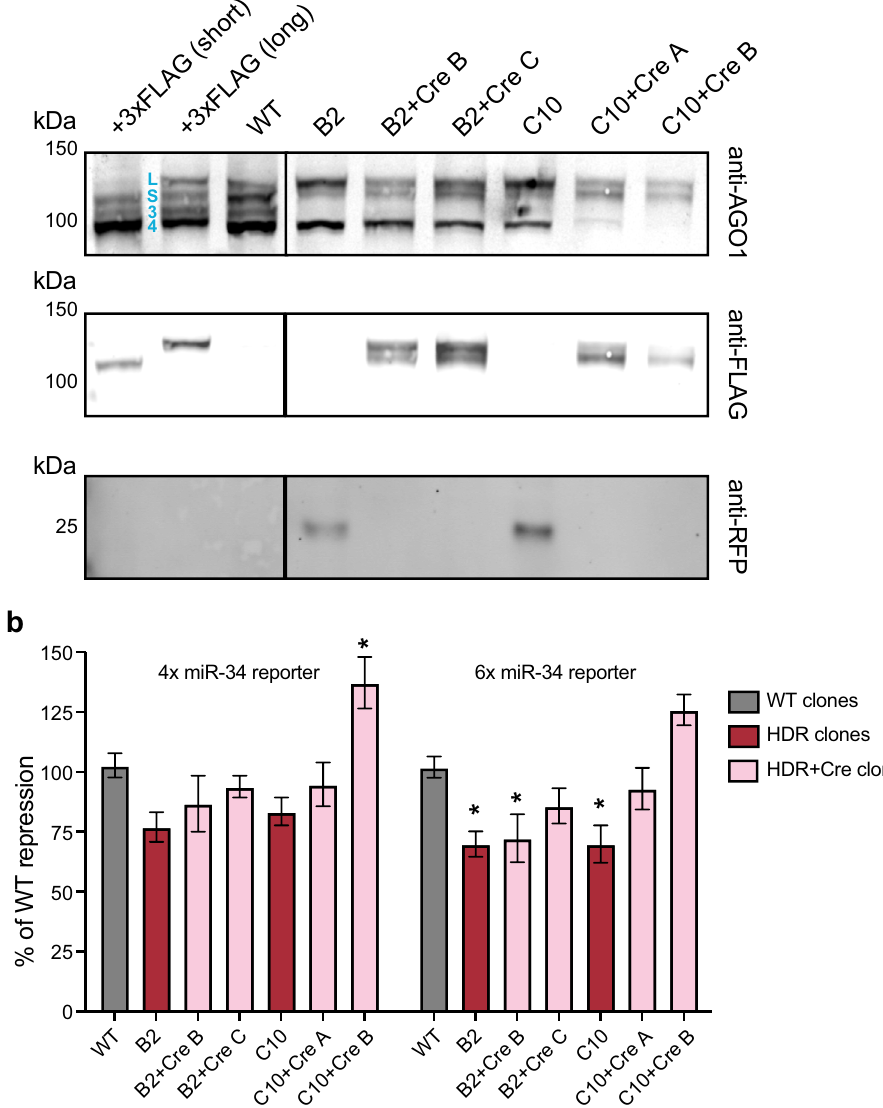
Figure 5. Characterization of AGO1 knock-in Aag2 cell lines. ( a ) Immunoblot of AGO1 (top) for wild-type (WT) and knock-in Aag2 clones. 3xFLAG-tagged Aag2 AGO1 short (blue S) and long (blue L) isoforms were detected by both the anti-AGO1 antibody and the anti-FLAG antibody (middle). Two shorter isoforms are indicated (blue 3, 4). 3xFLAG-tagged long and short AGO1 isoforms are detected in clones established following Cre excision (+ Cre A, B, C) and are expressed from the endogenous AGO1 locus. RFP (bottom) is detected in clones with the integrated HDR donor template (B2, C10) but not in clones established following Cre excision. Full-length immunoblots in Supplementary Fig. 4. ( b ) Luciferase reporter assay measuring repression of 4 or 6 repeated miR-34 sites (4 ×, 6 × miR-34 reporter). Normalization was performed as in Fig. 3e. The percent (%) of repression compared to WT is shown. p < 0.0001 (overall ANOVA comparing different clones); individual groups were compared using the Dunnett’s post hoc test compared to WT cells; * p <